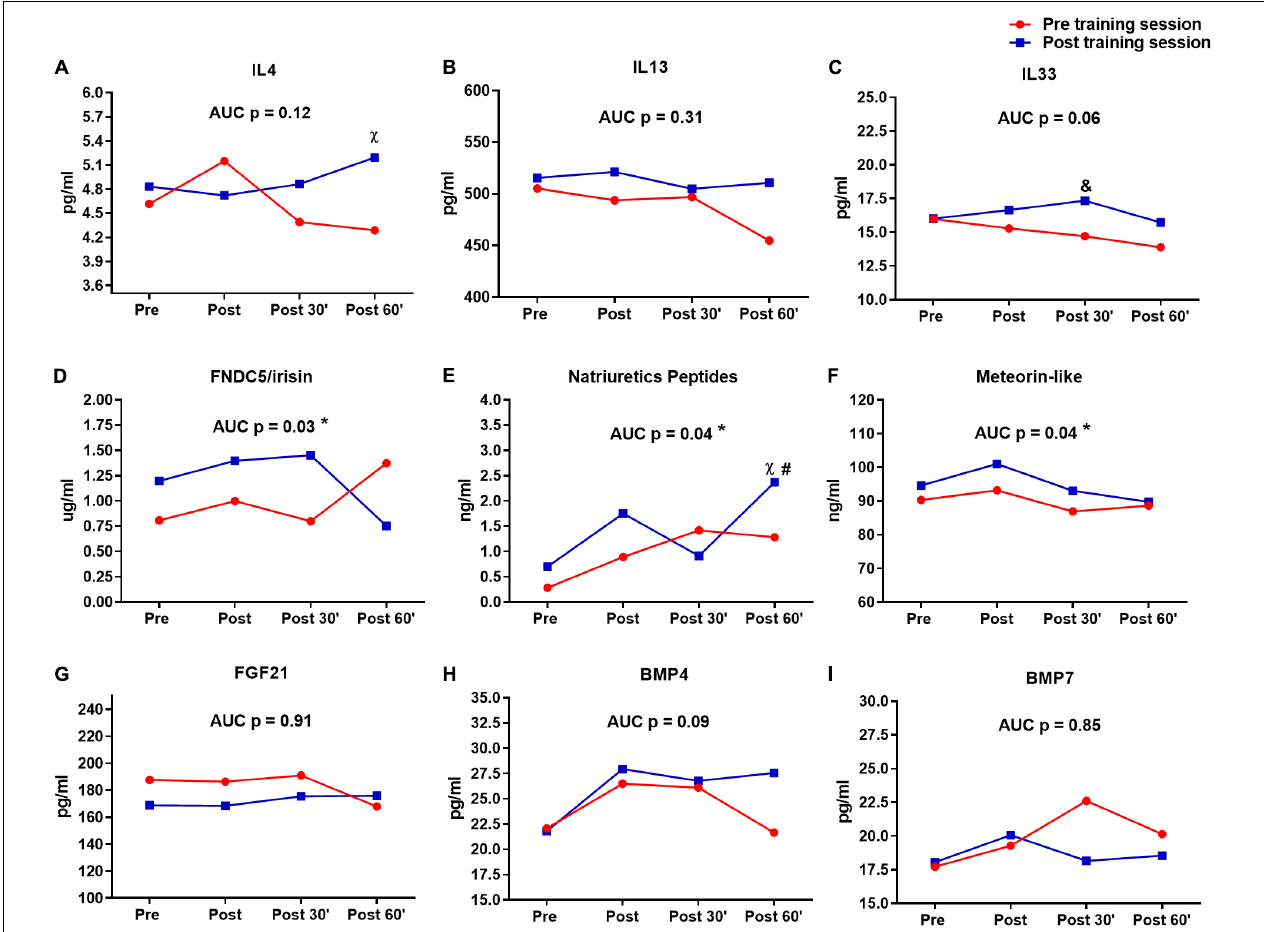
FIGURE 5 | Serum pro-thermogenic/anti-inflammatory inductors time-course in the pre- and post-training sessions. (A) IL4. (B) IL 13. (C) IL33. (D) FNDC5/irisin. (E) Natriuretic peptides. (F) Meteorin-like. (G–I) BMP7. & P < 0.05 (Tukey post hoc after group × time interaction in ANOVA), difference between sessions in moment 30 (cid:48) . χ P < 0.05 (Tukey post hoc after group × time interaction in ANOVA), difference between sessions in moment 60 (cid:48) . # P < 0.05 (Tukey post hoc after group × time interaction in ANOVA), difference to moments pre and post of pre training session. * P < 0.05 (dependent t -test), difference between sessions in area under curve (AUC). n = 15 per group, except FNDC5/irisin n = 8; and natriuretic peptides n = 12, both in feeding group. Values are in